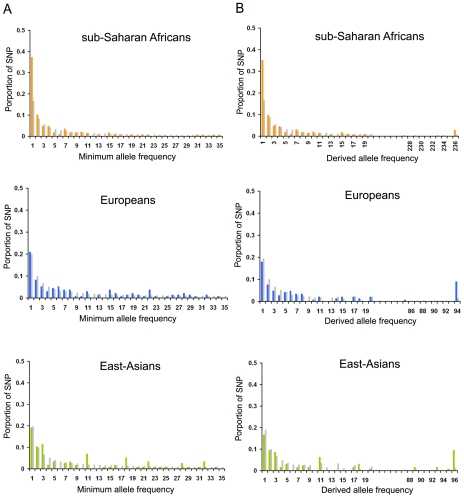
Minor allele and derived allele frequency spectra.(A) Minor allele frequency (MAF) and (B) derived allele frequency (DAF) spectra computed by merging the 20 non coding autosomal DNA sequences. The expected MAF and DAF spectra (grey bars) were obtained assuming constant population sizes (Material and Methods). To focus on low frequency bins, the MAF spectrum display values lower than 35 counts in each continental population. To show the derived alleles that are fixed in each continental population, we arbitrarily removed intermediate bins in the DAF spectrum.